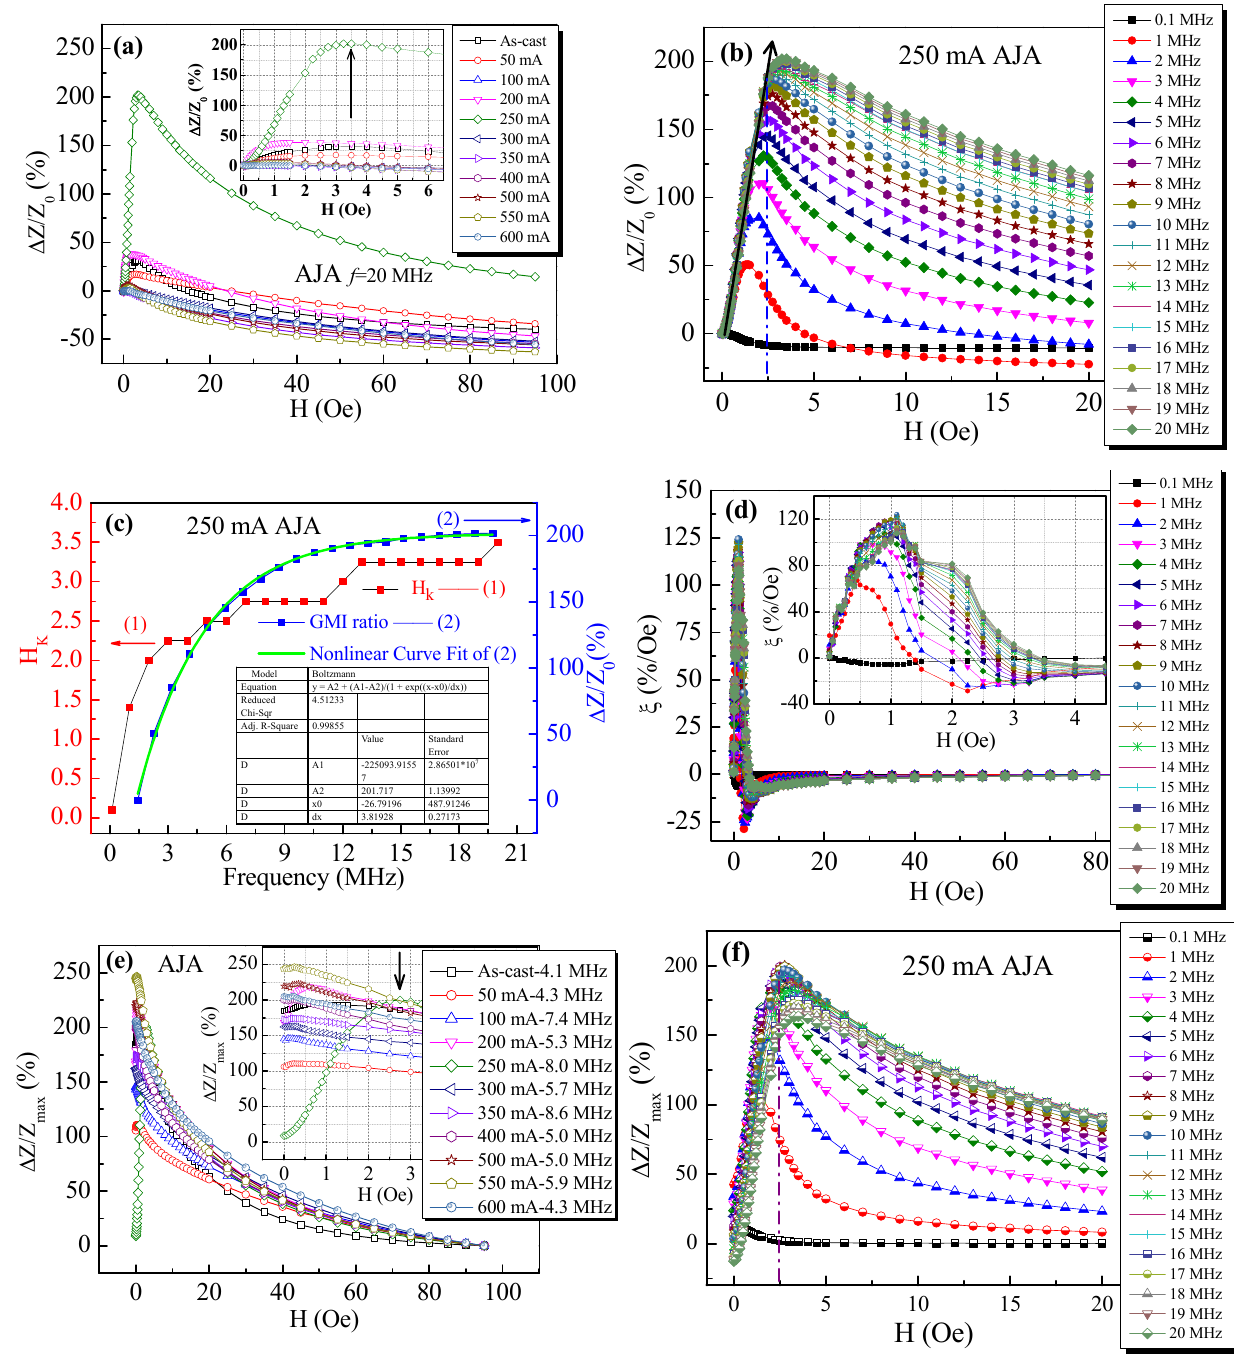
Figure 3. ( a ) Field dependence of the GMI ratios ( Δ Z / Z 0 %) for AJA ‐ ed microwires with the annealing current in the range of 0~600 mA at f = 20 MHz; ( b ) Field dependence of the GMI ratios ( Δ Z / Z 0 %) for 250 mA AJA ‐ ed microwire at the selected frequencies; ( c ) Anisotropy field H k and the Δ Z / Z 0 % ratios dependence of the frequencies f for annealing the current amplitudes of the 250 mA AJA ‐ ed microwire; ( d ) Field dependence of the field sensitivity ξ (%/Oe) for the different frequencies; ( e ) Field dependence of the GMI ratios ( Δ Z / Z max %) for the AJA ‐ ed microwires with annealing current in the range of 0~600 mA at the selected frequencies; ( f ) Field dependence of the GMI ratios ( Δ Z / Z max %) for the 250 mA AJA ‐ ed microwire at selected frequencies. Figure 3c illustrates the anisotropy field H k and the impedance ratio [ Δ Z / Z 0 ] max (%) of the 250 mA AJA microwire dependence of the excitation frequency. Both the [ Δ Z / Z 0 ] max (%) reach to the maximum values at f = 20 MHz. The impedance ratio is nonlinear fitted and